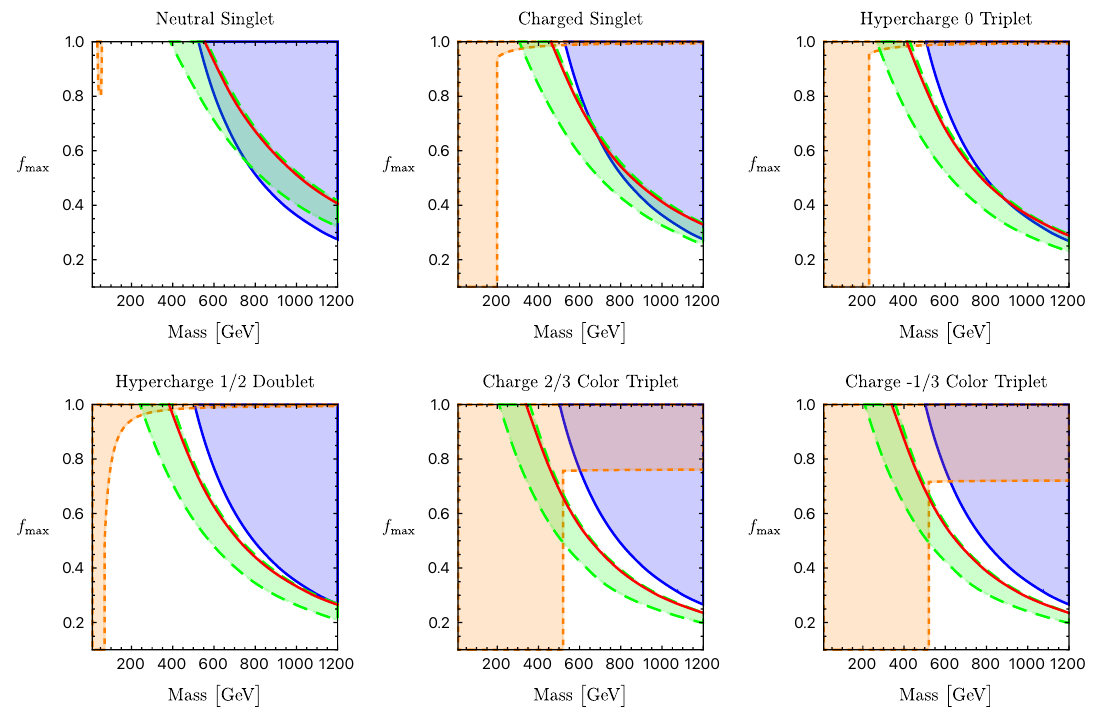
Figure 1 . The allowed parameter space for which there is a strongly first-order electroweak phase transition. The mass quoted is the physical mass of the Loryon. f max is the fraction of its mass- squared the particle gets from its coupling to the Higgs; f max > 1 / 2 is the condition for a Loryon. The orange region (dotted boundary) is ruled out by experimental constraints; the blue region (solid boundary) is ruled out by perturbative unitarity. The green region (dashed boundary) is where a strongly first-order phase transition is predicted. The solid red line through this region is the lower bound for production of a stochastic gravitational wave background detectable by LISA, which is only marginally below the upper bound for an appropriate phase